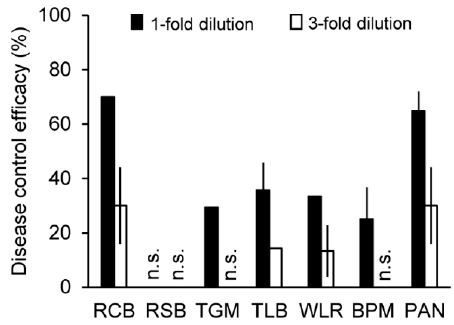
Figure 1. Antifungal activity of the culture filtrate of the IUM00035 isolate. Plant disease control values of the culture filtrate of the IUM00035 isolate. RCB, rice blast; RSB, rice sheath blight; TGM, tomato gray mold; TLB, tomato late blight; WLR, wheat leaf rust; BPM, barley powdery mildew; PAN, pepper anthracnose. n.s. indicates not shown, meaning that disease control effects of the culture filtrate were not observed.